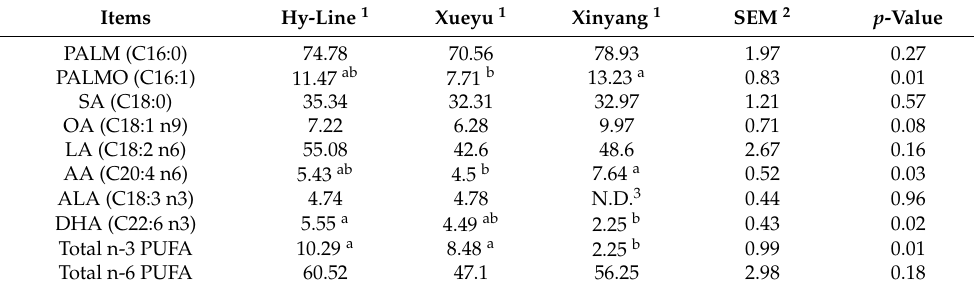
Table 5. Fatty acid of egg yolks from Hy-Line, Xueyu, and Xinyang laying hens (mg/g).